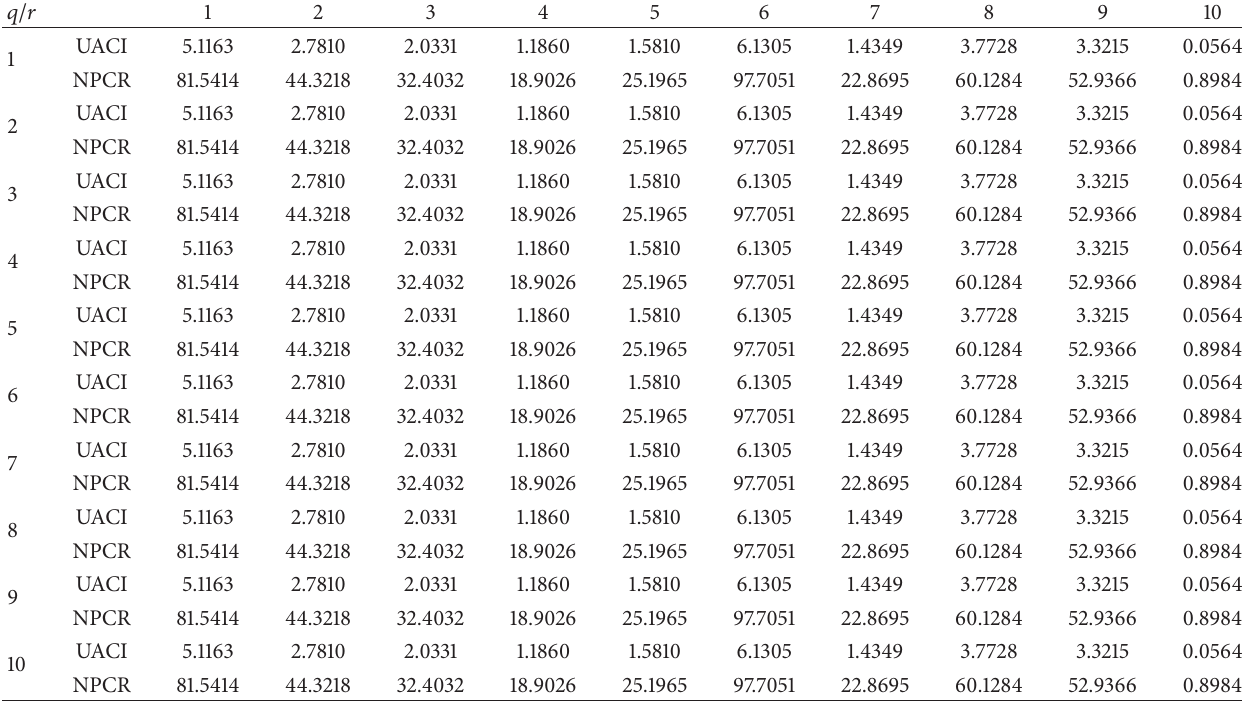
Table 8: Calculated UACI and NPCR for different combinations of 𝑞 and 𝑟 while 𝑝 = 1 in Peppers.